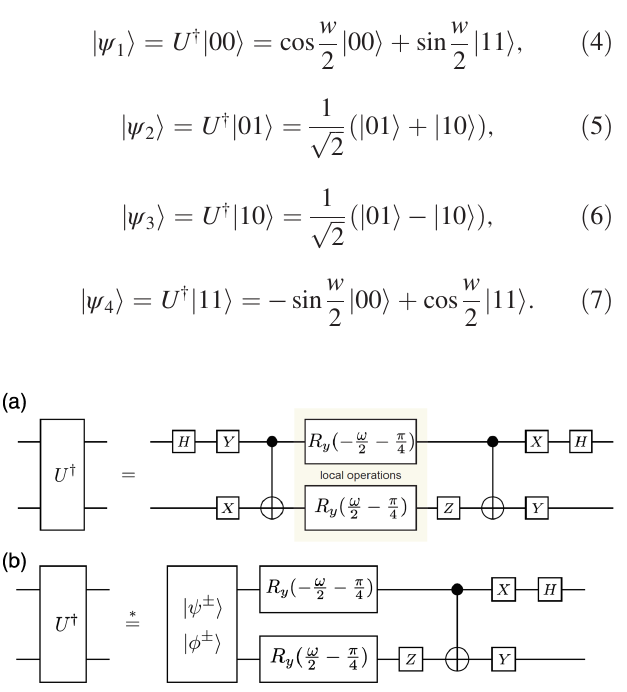
FIG. 2. Schematic of the experimental setup implementing U † [Fig. 1(b)]. A pair of photons — polarization-encoded qubits — is both created and initialized to a desired state via spontaneous parametric down-conversion. Different Hamiltonians can flexibly be simulated be tuning the parameter w ¼ arctan ½ð J x − J y Þ =B (cid:2) through local unitary operations (LU) wrapped in between two CNOT operations. The former CNOT is thus merged with the SPDC process, while the latter is implemented by a combination of two-photon interference and polarization-dependent beam splitters